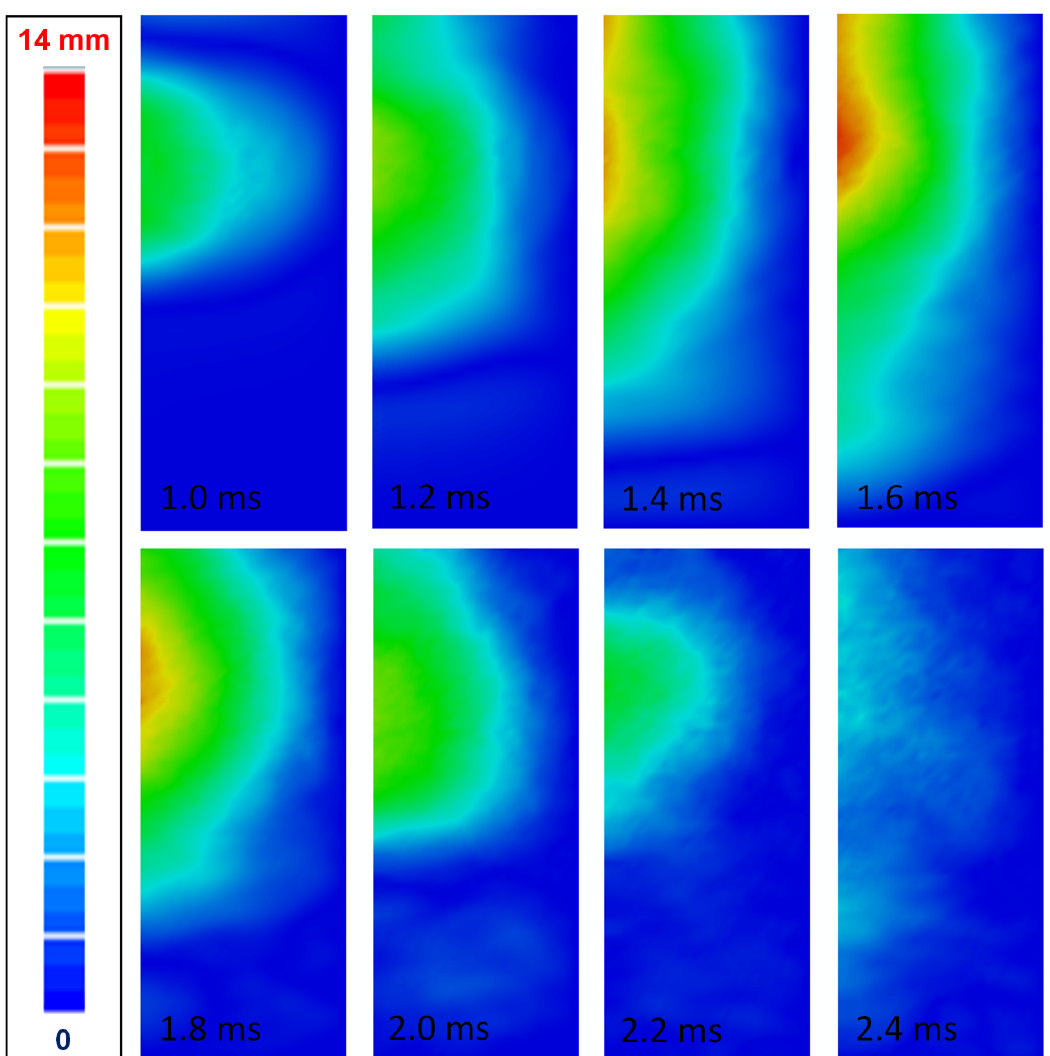
Figure 8. Deformation magnitudes of the composite plate with the root and one side edge clamped boundary condition during the bird impact.